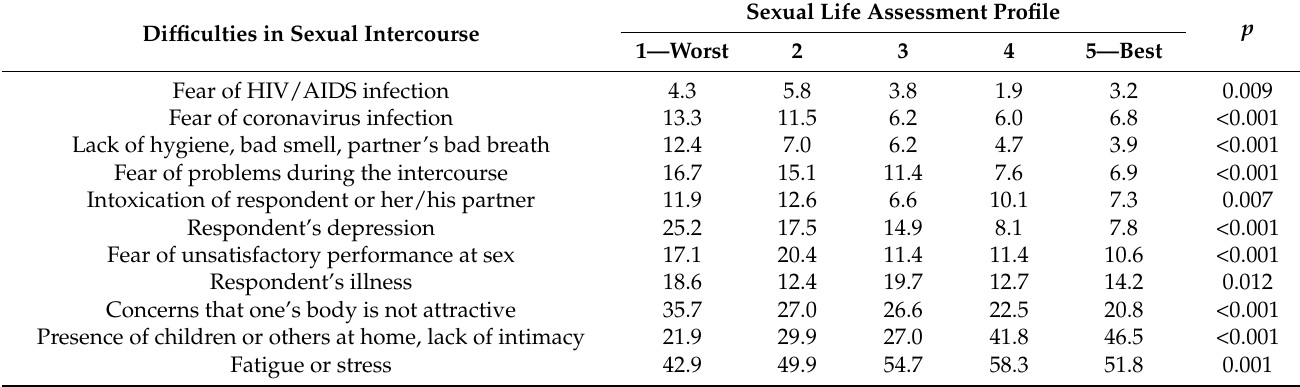
Table 5. Selected difficulties in initiating sexual intercourse (%) in groups representing different profiles of sexual life assessment (combined 2020 and 2021 data; n = 2453 respondents reporting at least one